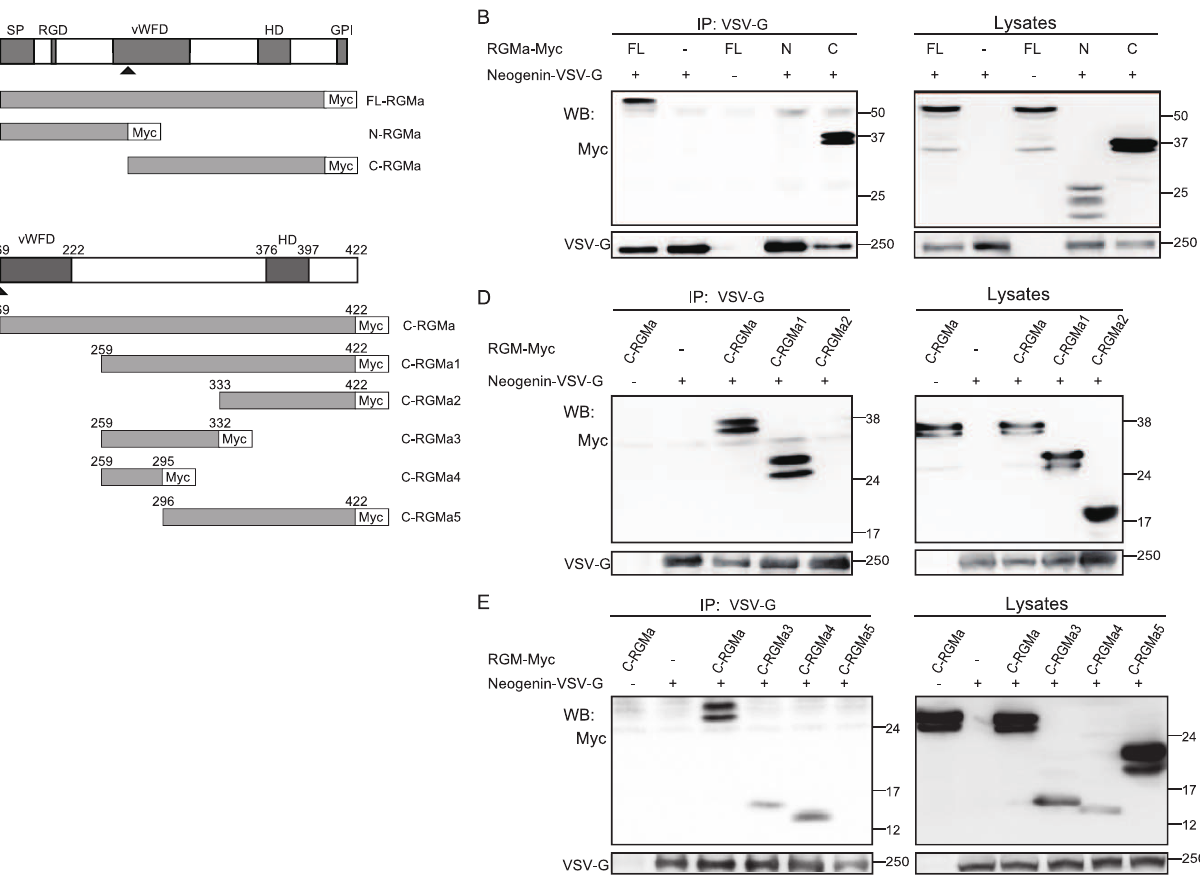
Figure 1. The RGMa domain required for binding to neogenin is within aa 259–295. (A and C) Schematic representation of RGMa and its deletion mutants are shown with their domain structures. Arrowhead shows potential cleavage site. SP: signal peptide, vWD: von Willebrand factor type-D domain, HD: hydrophobic domain, GPI: GPI-anchor. (B, D, and E) Co-immunoprecipitation of full-length neogenin-VSV-G with the deletion mutants of RGMa-Myc. HEK293T cells were transiently transfected with the indicated plasmids. Cell lysates were immunoprecipitated with the anti- VSV-G antibody. The immunoprecipitates (IP) and cell lysates (Lysates) were analyzed by western blotting with anti-Myc and anti-VSV-G antibodies.